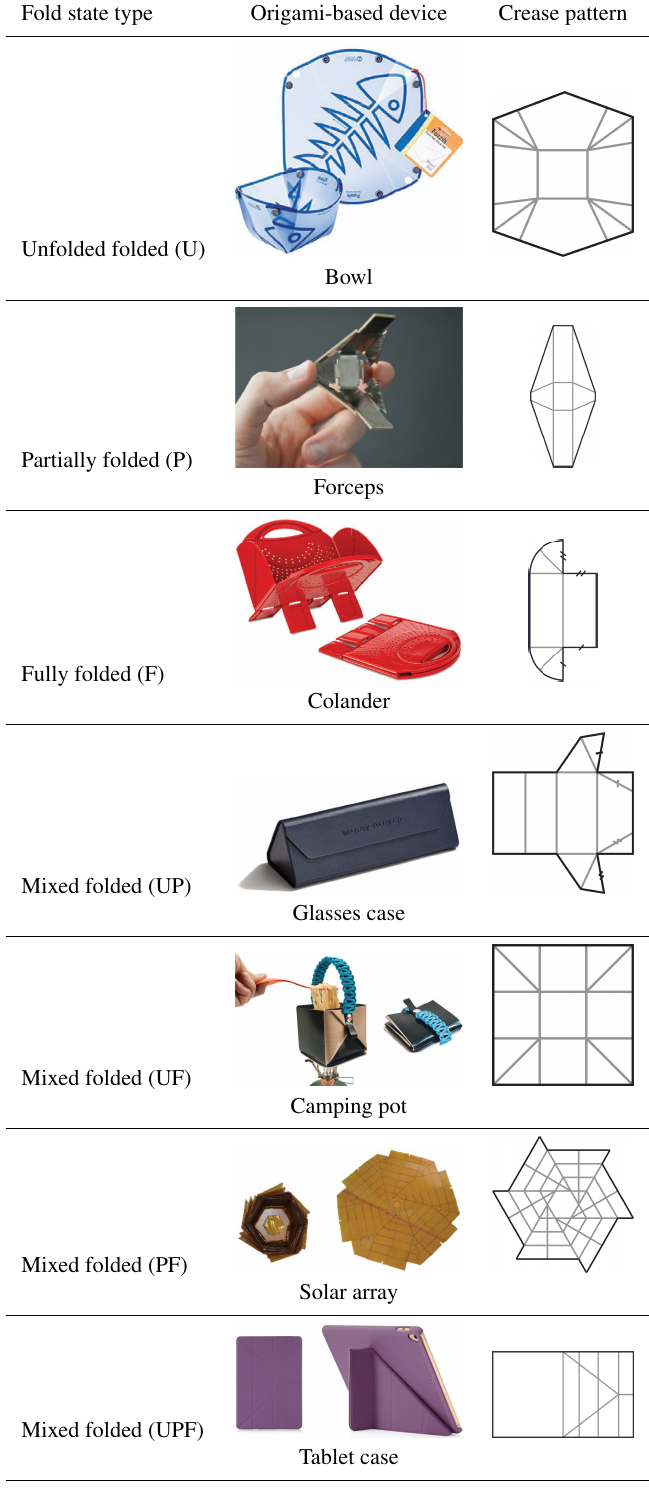
Table 1. Examples of origami-based device for each fold state. Bowl (Fozzils ™ ) (Fozzils, 2018), Forcpdf(Morgan et al., 2017), Colander (B&R Plastics Inc ™ ) (Plastics Inc., 2018), Glasses Case (Warby Parker ™ ) (Parker, 2018), Camping Pot (Bear Minimum ™ ) (Minimum, 2018), Solar Array (Zirbel et al., 2013), and Tablet Case (Pipetto ™ ) (Pipetto, 2018). The hashes on the crease pattern indicate where facets are connected. All figures are used with permission by their respective